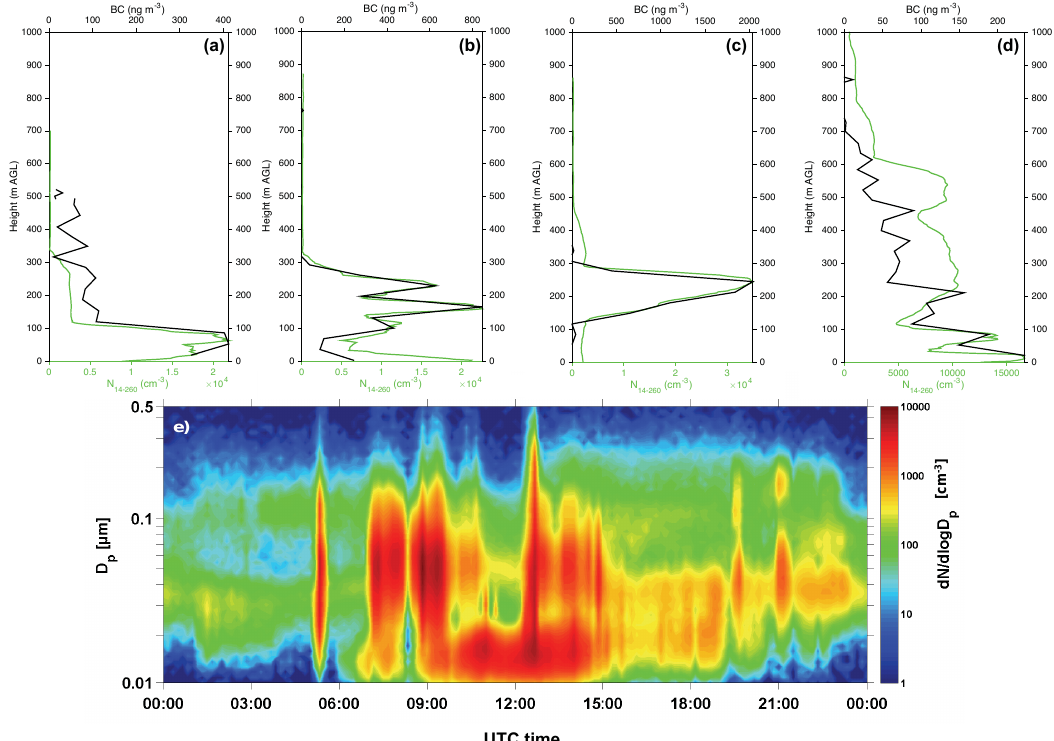
Figure 12. Case study of 6 July 2011 when four ships anchored (not simultaneously) in the harbor of Ny-Ålesund. Vertical profiles of N 14 − 260 (green line) and BC (black line) (07:40, 09:01, 09:32 and 13:40UTC) are reported in panels from (a) to (d) together with ground SMPS data collected at Gruvebadet (e) . Note the change in BC scale to progressively increasing BC values during the peak of the ship activity at